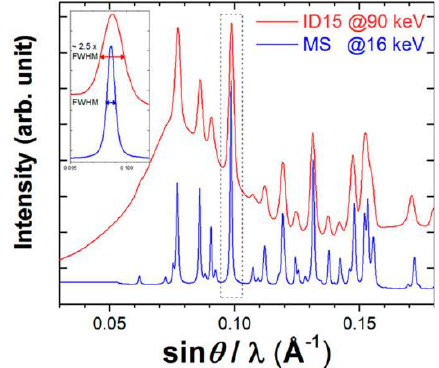
Figure 6. In situ powder pattern measured at ESRF ID15 beamline (Grenoble, France) with a shaker mill (red top curve) compared to the new mill design used at SLS MS beamline (Villigen, Switzer- land) (blue bottom curve) for the reaction between LiBH 4 and CsBH 4 . Reprinted with permission from [54]. Copyright 2017, American Chemical Society.